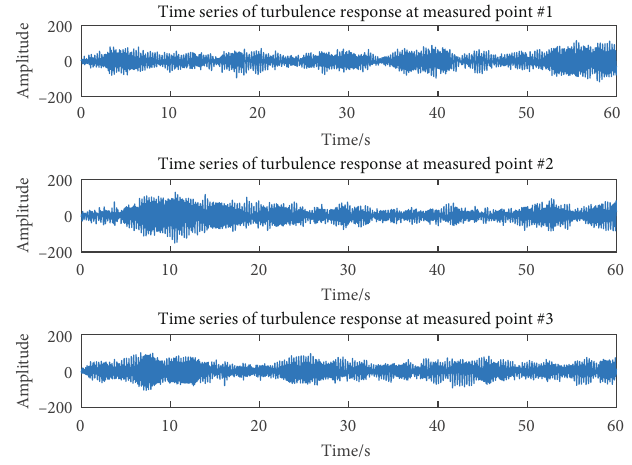
Figure 9: Time series of three-mode turbulence